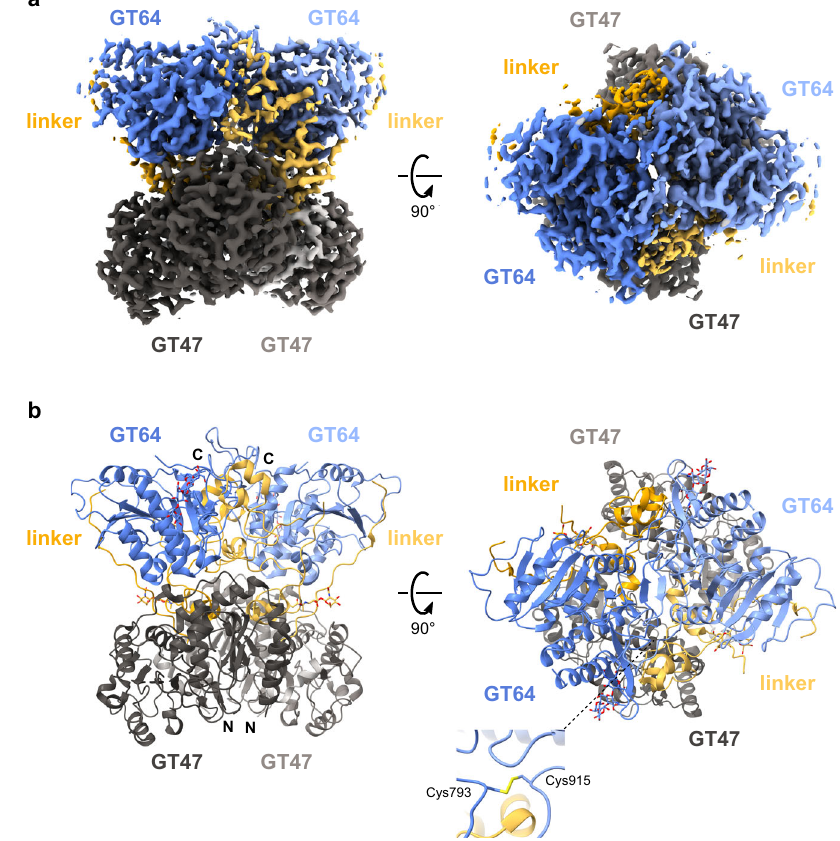
Fig. 3 Cryo-EM structure of the homodimeric globular domain of EXTL3. EXTL3 Δ N was puri fi ed and subjected to cryo-EM single particle analysis, achieving a resolution of 2.4 Å. a Cryo-EM density map. Domains are coloured-coded as in Fig. 1a (GT47: dark grey; inter-domain linker: yellow; GT64 blue). b Fitted model, coloured-coded as in panel a. The N- and C-termini are labelled for each